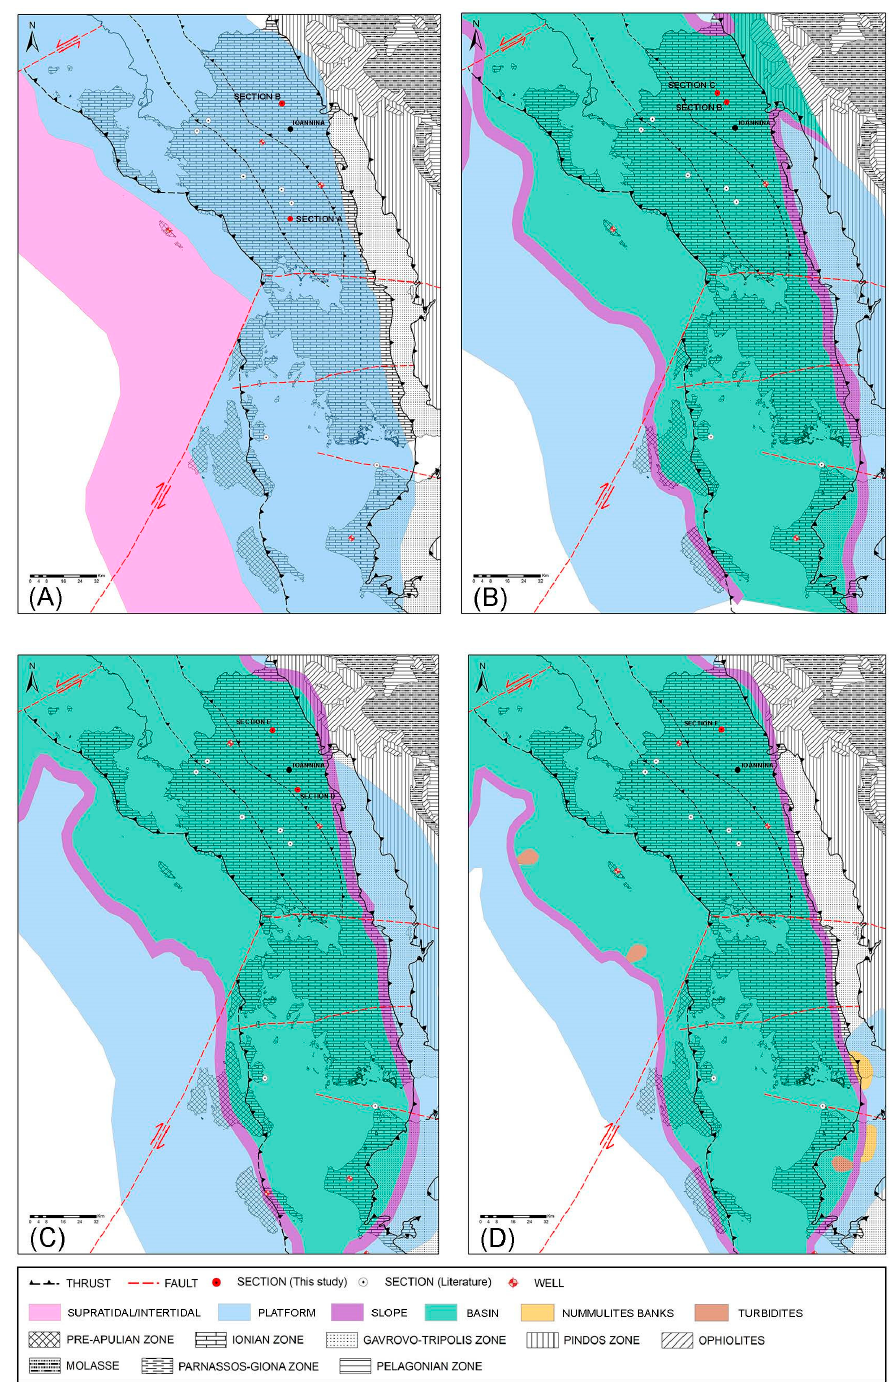
Figure 8. Paleo-environmental map of the study area during the ( A ) Early Jurassic, ( B ) Early Cretaceous, ( C ) Late Cretaceous, and ( D ) Paleocene-Eocene based on outcropped- (red circles from this study and white ones from the literature) and well-data (white-red symbols) [33,35,42,59,86].